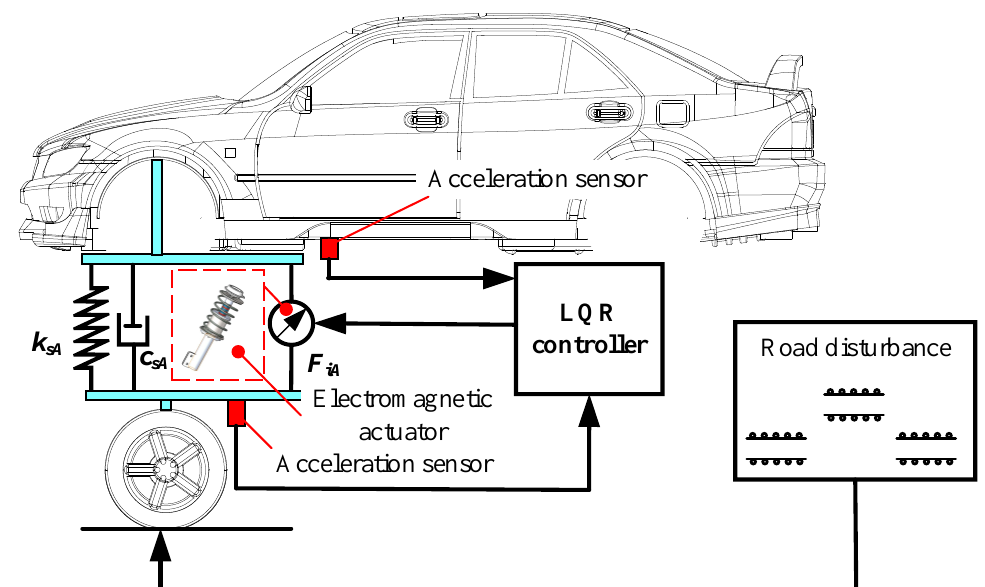
Figure 2. Schematic of the electromagnetic active suspension with LQR controller.